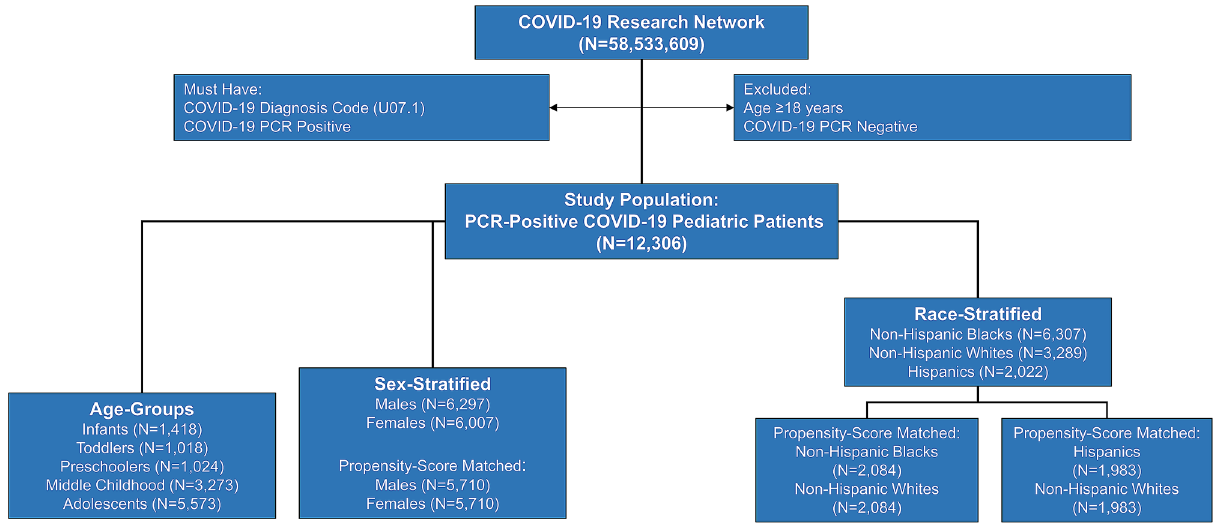
Figure 1. Derivation of study